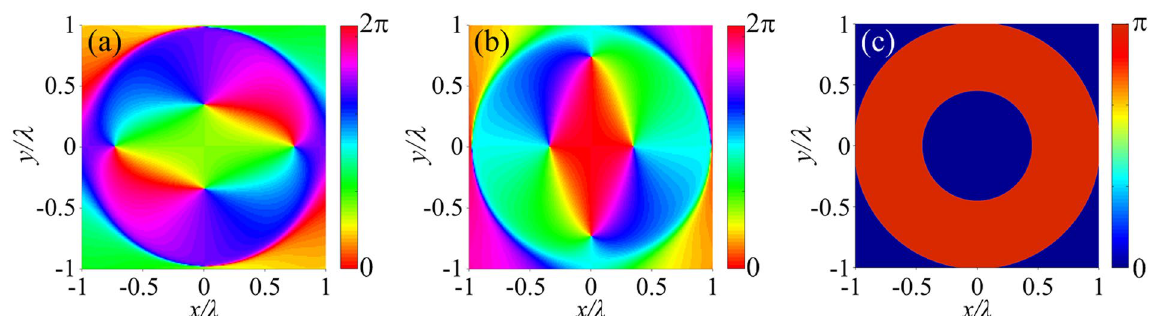
Figure 4. Phase distribution of the electric field on the focal plane of the first-order SZP illuminated by an AP Bessel-Gaussian beam. ( a ) Argument of the x -component of the electric vector. ( b ) Argument of the y - component of the electric vector. ( c ) Phase of the total electric field according to Pancharatnam’s